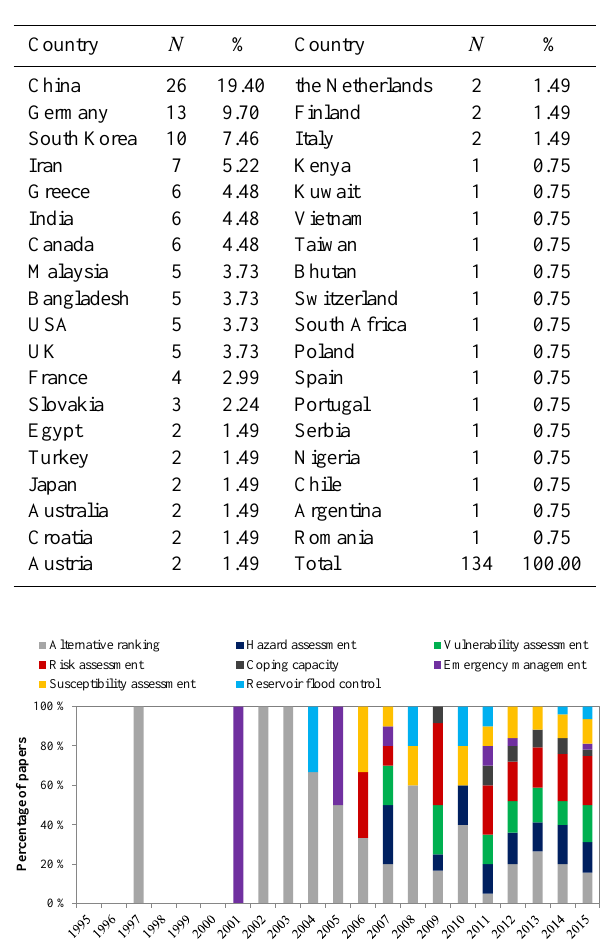
Table 3. Distribution of applications by country of application.